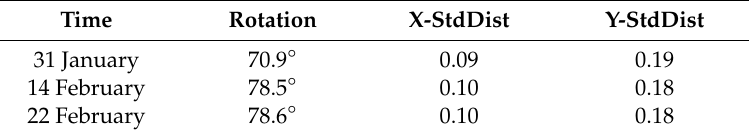
Figure 5. The SDE of the spatial distribution of epidemic sites. Table 2. The parameters of the SDE at different time nodes.